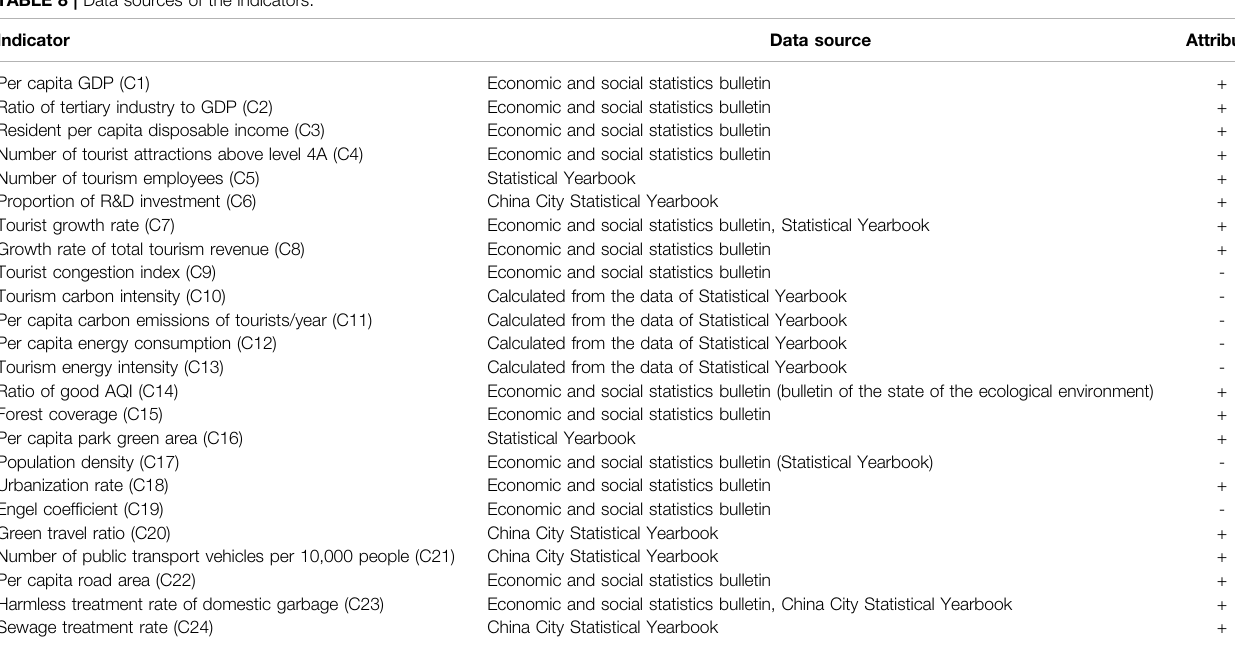
TABLE 8 | Data sources of the